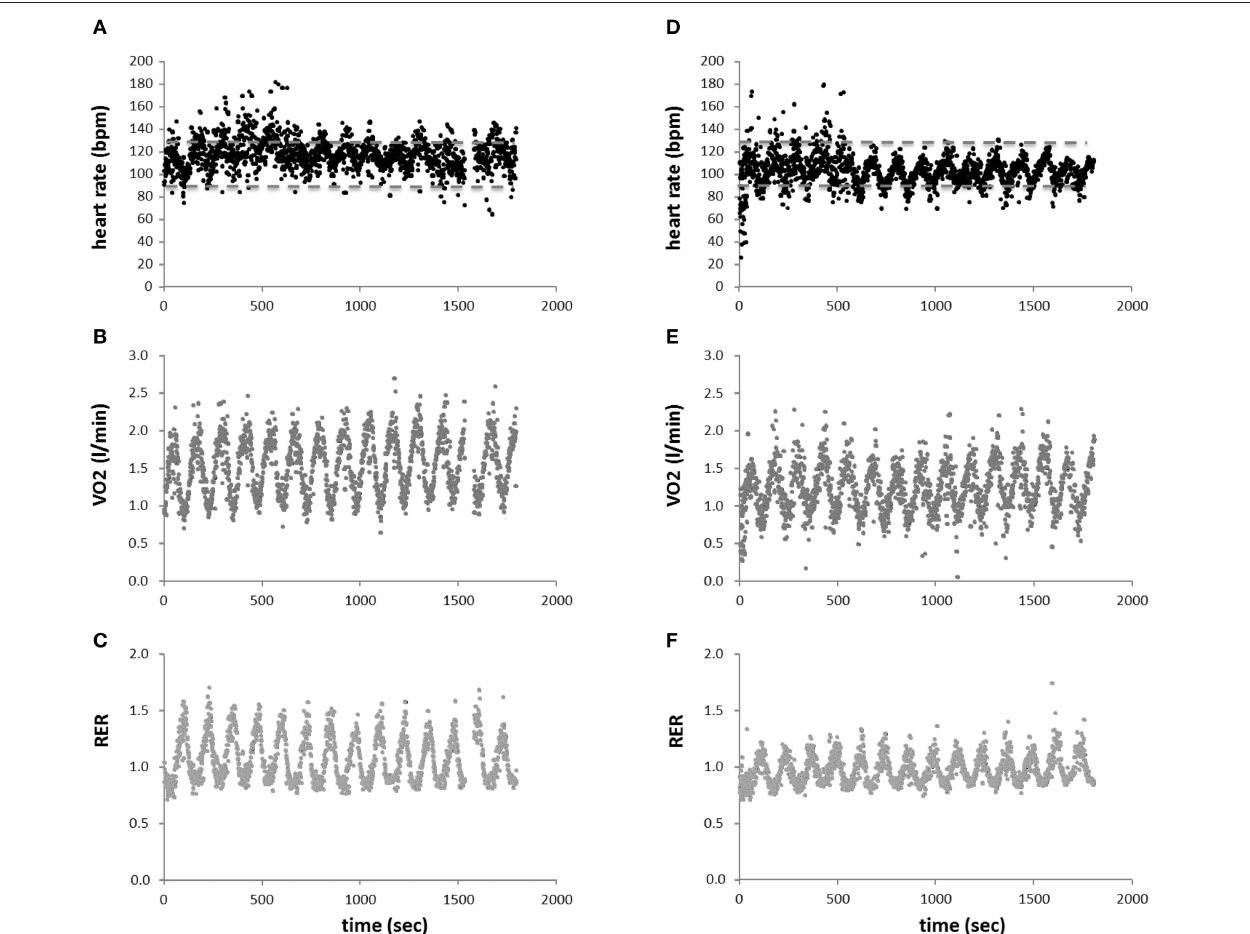
FIGURE 4 | Respiration during interval exercise. Scatter plot of average heart beat (A,D) , oxygen uptake (B,E) , and respiration exchange ratio (RER) (C,F) , over all subjects in function of time over all performed sets of interval-type concentric (A–C) and eccentric (D–F) exercise. Stippled lines in (A,D) indicate upper and lower limits of the interval zone being recommended for the cardiac patient (i.e., 50–70% of peak heart rate). Note the periodic influence of the intervals of exercise and